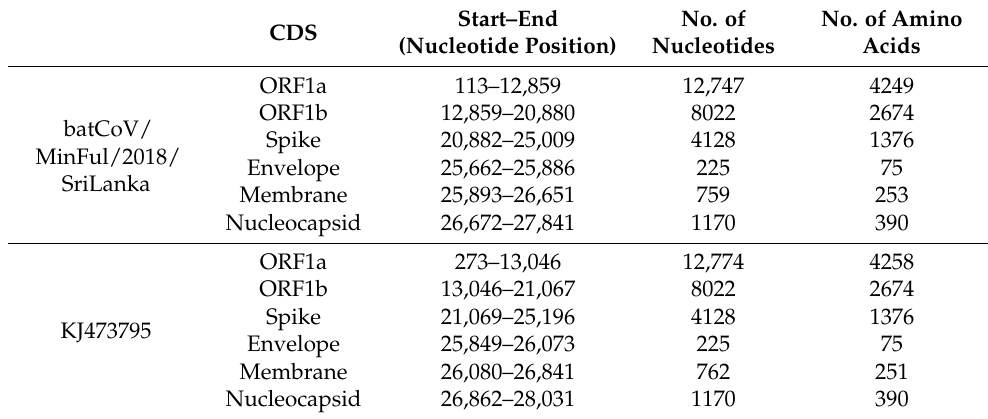
Table 2. Annotated coding sequences (CDS) of the novel batCoV/MinFul/2018/SriLanka strain